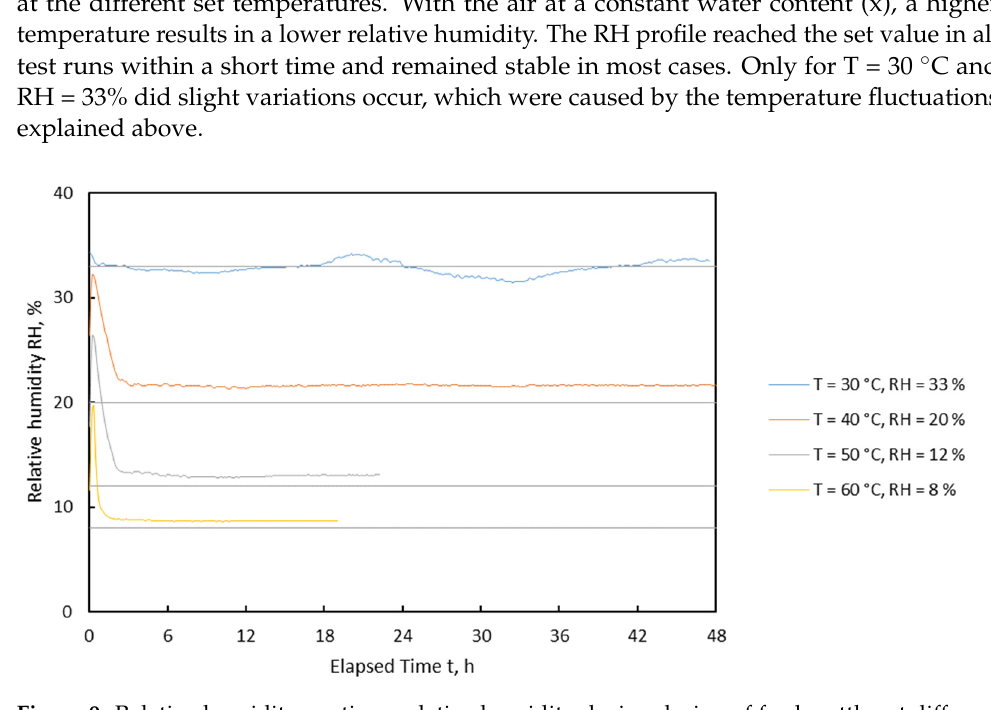
Figure 10. Calculated water content vs. time; calculated water content of air during drying of fresh nettles with different temperatures in the HPD TP3+; x set = 0.01, v set = 0.2 m·s − 1 .